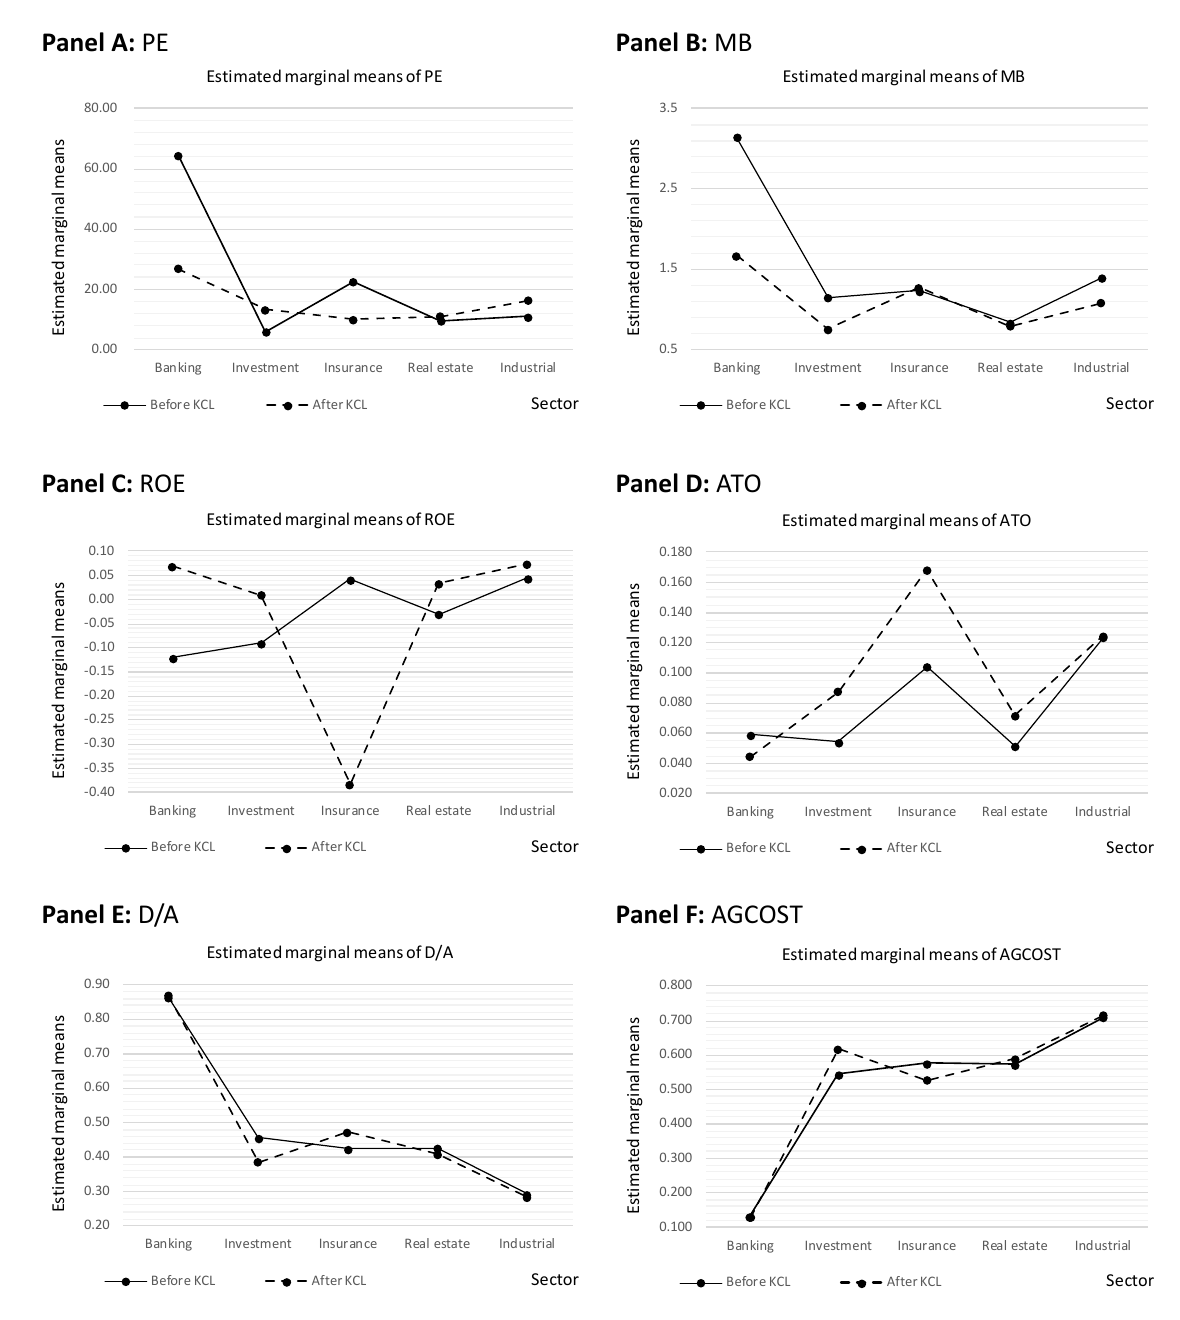
Figure 2. Plot of means before and after